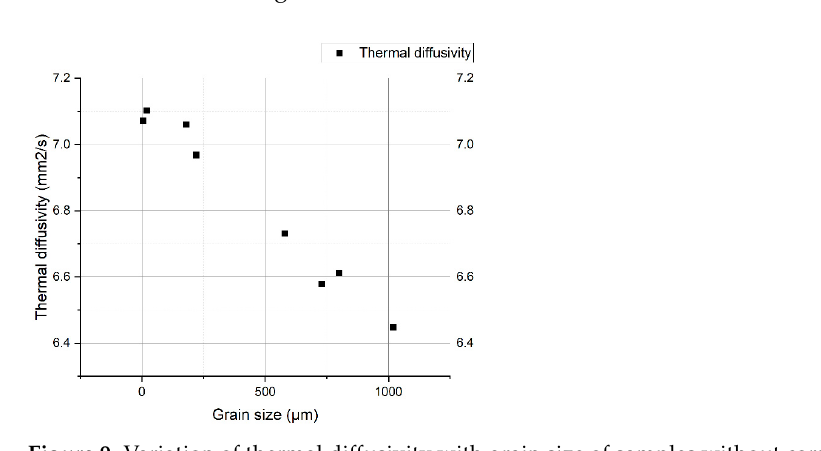
Figure 9. Variation of thermal diffusivity with grain size of samples without corrosion layers. In order to highlight the role of the transformations that occur when the alloy is heated to 1050 °C and for cooling, continuous diffusivity determinations were made for a heating = cooling cycle, without maintenance at 1050 °C and a heating–cooling cycle with maintenance of 30 min at 1050 °C (Figure 10). Figure 10. Variation of the thermal diffusivity of the sample during a treatment cycle consisting of heating at 1050 °C and cooling, with maintenance and without maintenance of 30 min at 1050 °C. Both curves showed that, without the presence of corrosion layers, the curves of the thermal diffusivity values determined at cooling are below those at heating. Maintaining a high temperature causes a significant decrease in diffusivity. 4. Interpretation of Results At the microstructural level, research has shown that the formation and increase of corrosion layers, mass transfer processes in the layer, through the oxide–metal and metal interface, associated with the transformations caused by high temperatures, lead to the formation of the following types of structures on the thickness of the sample: •